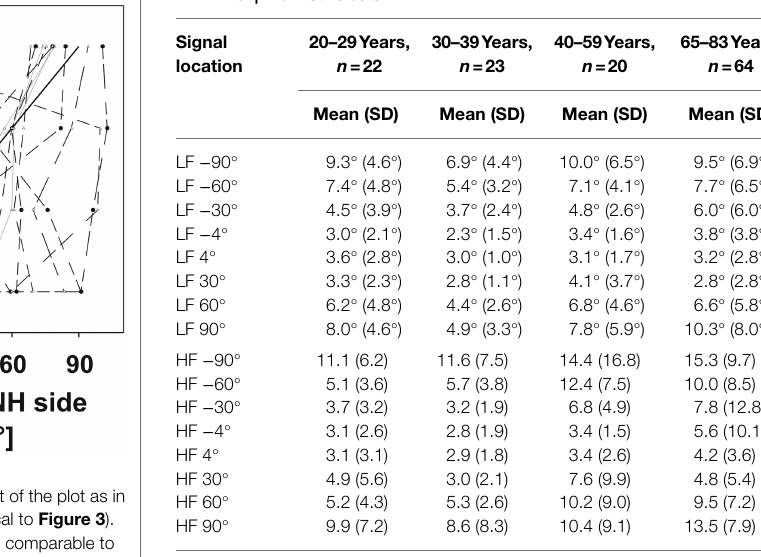
TABLE 3 | Normative